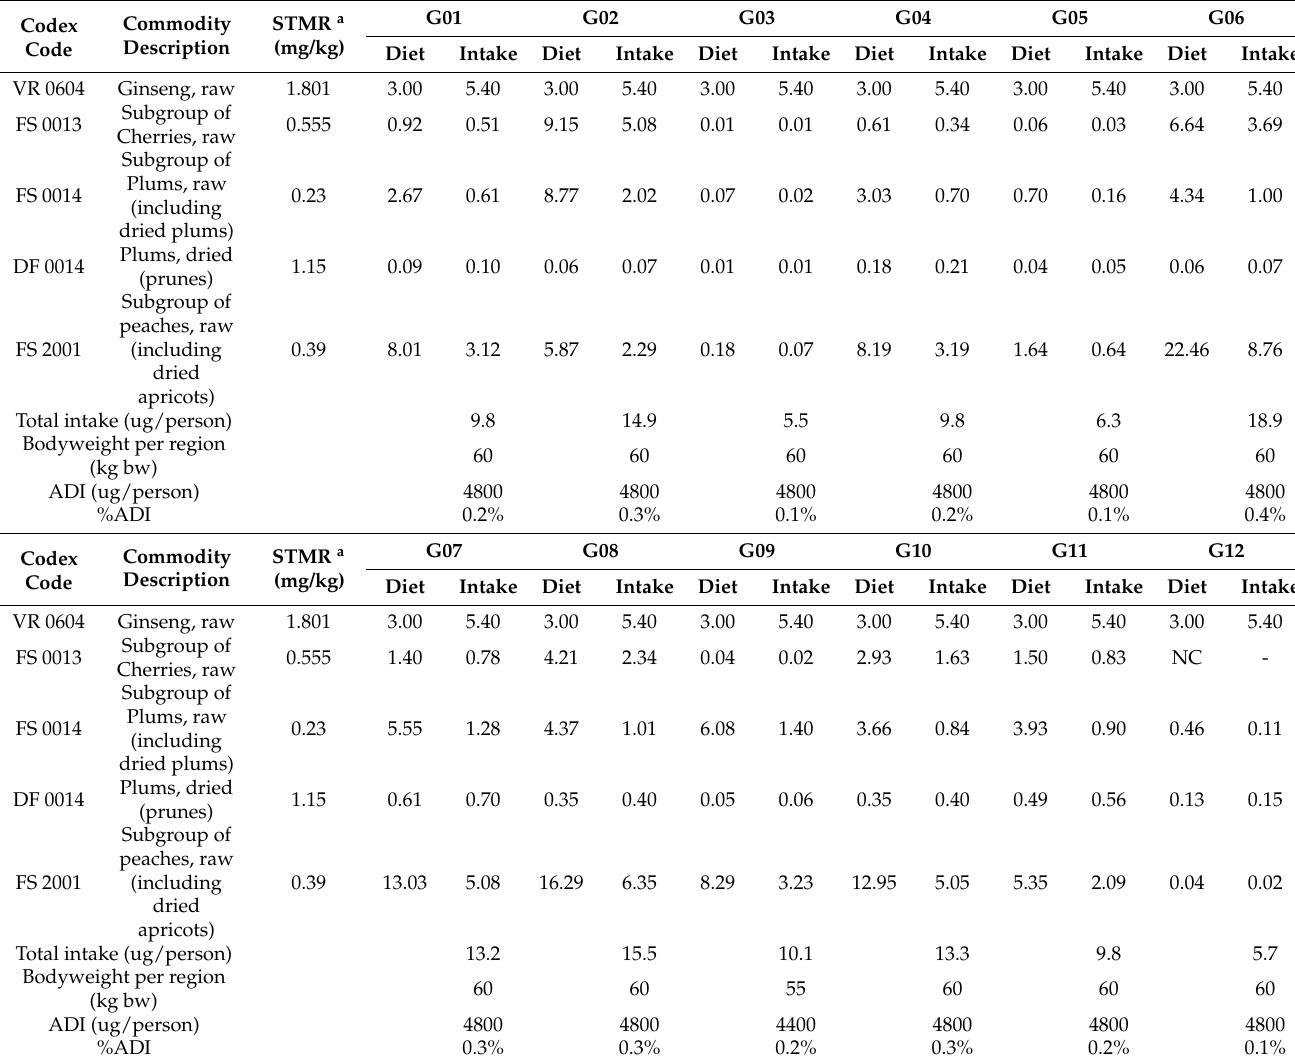
Table 4. The long-term and short-term dietary intake risk assessment of flupyradifurone based on the Chinese dietary